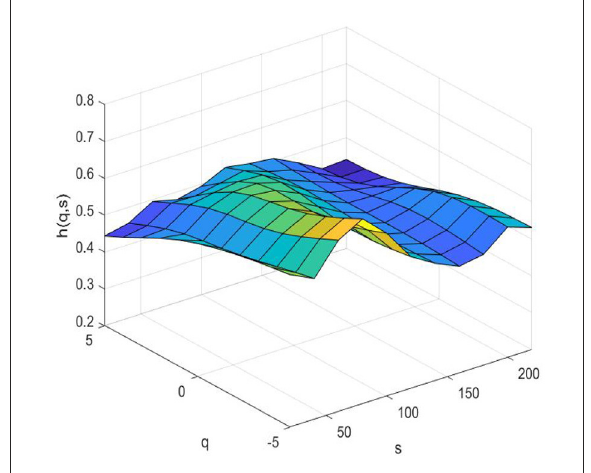
FIGURE3 Risk spillover of the system (pre–pandemic).